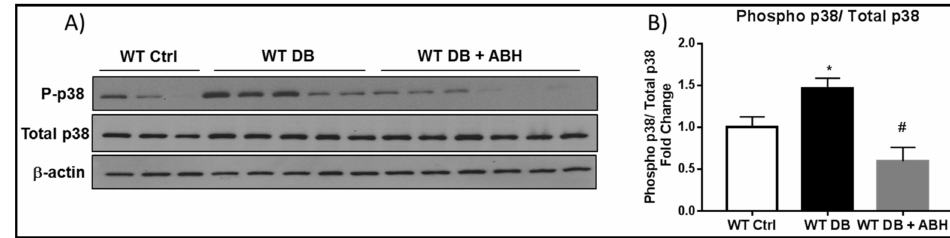
Figure 5. Diabetes induced- increases in phospho p38 is prevented by inhibiting arginase. ( A ) Western blot analysis and quantification ( B ) showing increased phosphorylation of p38 in WT diabetic retinal extracts compared to age matched controls. ABH treatment significantly blocked this increase. * p < 0.05 vs. WT Ctrl. # p < 0.001 vs. WT DB. n = 6–8.